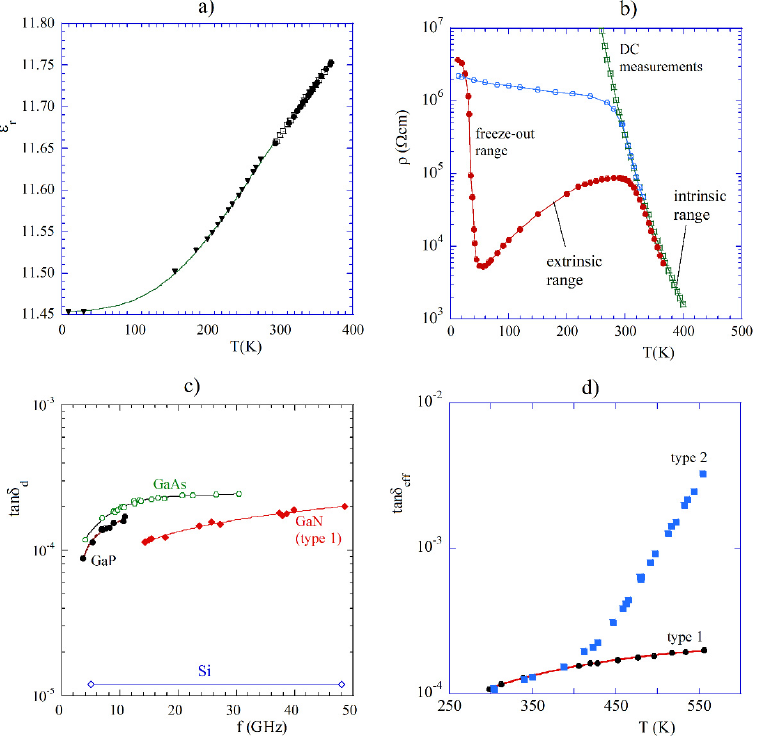
Figure 8. ( a ) Permittivity of high resistivity silicon sample having nominal resistivity of about 13 k Ω cm at room temperature [58] © IEEE Publishing. Reproduced with permission. All rights re- 13 k Ω cm at room temperature [58] © IEEE Publishing. Reproduced with permission. All rights served. ( b ) Resistivity of high resistivity silicon samples measured with 𝑇𝐸 (cid:2868)(cid:2869)(cid:3083) mode dielectric res- onator technique. Red solid points correspond to the as-grown float zone (FZ) silicon sample, having reserved. ( b ) Resistivity of high resistivity silicon samples measured with TE 01 δ mode dielectric nominal resistivity of about 85 k Ω cm at room temperature [59]. Open blue circles correspond to FZ resonator technique. Red solid points correspond to the as-grown float zone (FZ) silicon sample, proton irradiated sample. DC resistivity measurements (green squares) have been performed on having nominal resistivity of about 85 k Ω cm at room temperature [59]. Open blue circles correspond another FZ proton irradiated sample. ( c ) The dielectric loss tangent, due to dielectric losses of semi- insulating semiconductors, at the temperature of 25 C. ( d ) The total dielectric loss tangent of two to FZ proton irradiated sample. DC resistivity measurements (green squares) have been performed kinds of GaN samples as a function of temperature at a frequency about 15 GHz [62]. on another FZ proton irradiated sample. ( c ) The dielectric loss tangent, due to dielectric losses of semi-insulating semiconductors, at the temperature of 25 C. ( d ) The total dielectric loss tangent of two kinds of GaN samples as a function of temperature at a frequency about 15 GHz